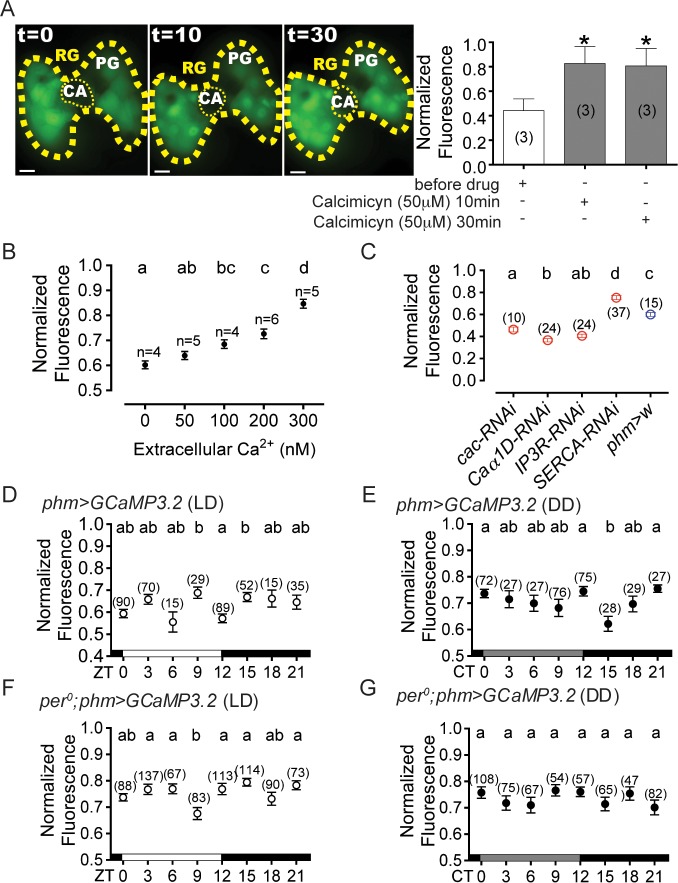
Calcium levels in the PG vary during the course of the day.(A) Left: Representative images of GCaMP fluorescence in the PG before (t = 0), and 10 min and 30 min after incubation with 50μM calcimycin (external [calcium]: 1mM) and Right: quantitation of the fluorescence in the PG; numbers in parenthesis indicate number of PG glands measured; *p<0.05 (paired t-test compared with signal measured before adding drug). (B) Dose response of GCaMP sensor measured using increasing extracellular calcium concentrations; n: number of PG cells (taken from at least 4 PGs per condition). (C) Levels of fluorescence in controls and in animals bearing knockdown of calcium channels (cacophony [cac] and Ca-alpha1D), IP3 receptor (IP3R) and SERCA in the PG (using phm-GAL4 driver)(all measured at ZT12). The number of cells analyzed is indicated above colored circle. For each experiment 4–8 animals were examined. Error bars denote SEM. (D-G) Levels of fluorescence in the PG of wildtype animals at different times of day under LD (D) and DD (E) conditions, and in the PG of per0 mutants under LD (F) and DD (G) conditions. Different letters indicate statistically significant differences (ANOVA with Tukey’s post hoc test). The number of cells is indicated in brackets and above each error bars. In A: PG: prothoracic gland, CA: corpus allatum, RG: ring gland. Scale bar 10μm; in A-G: Normalized fluorescence is quantitated in arbitrary units.